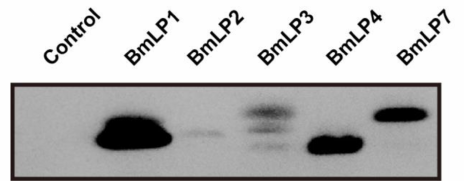
Figure 4. Fungal binding assay of BmLP1, BmLP2, BmLP3, BmLP4 and BmLP7 revealed using western blotting. Purified proteins in PBS were incubated with fungal under shaking for 2 h at room temperature. Subsequently, the fungal cells were pelleted, washed four times with PBS, and resuspended in PBS. Western blotting was performed using mouse anti 6 × his-tag antibodies and HRP-conjugated goat anti mouse antibodies. Control: no